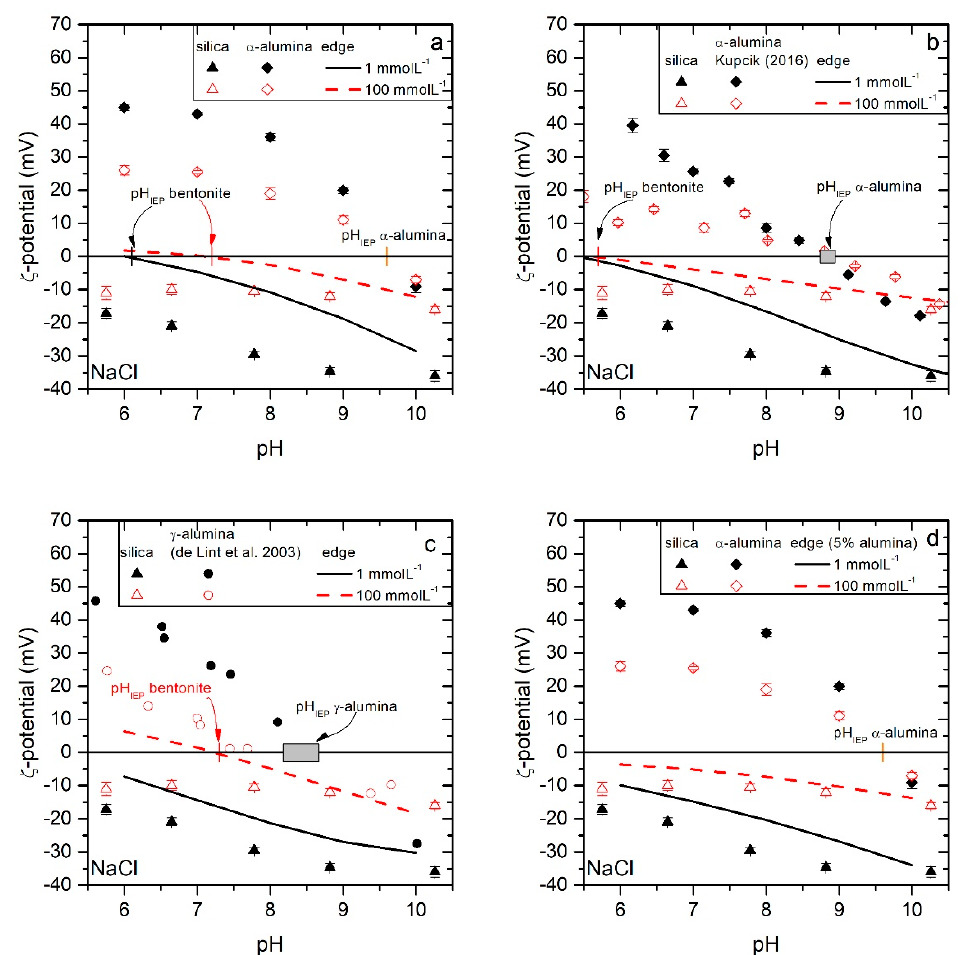
Figure 7. Measured silica (triangles) and α -alumina (diamonds) ζ -potentials at 1 mmol · L − 1 (filled symbols) and 100 mmol · L − 1 (open symbols) are plotted in ( a ). The lines indicate the estimated edge electrokinetic potential with a structural Al-ratio of 10.32% for the two electrolyte concentrations. The edge electrokinetic potential is also estimated using α -alumina ζ -potentials taken from Kupcik et al. [71] ( b ) and γ -alumina ζ -potential taken from de Lint et al. [72] ( c ). For Figure ( d ), the edge electrokinetic potential is calculated with a structural Al-ratio of 5%.